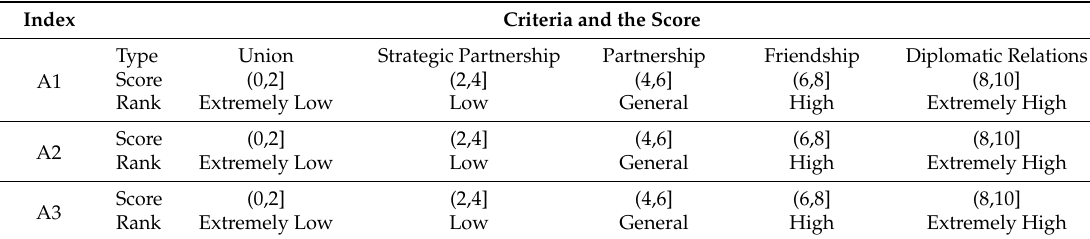
Table 4. Evaluation criteria of the political risk.